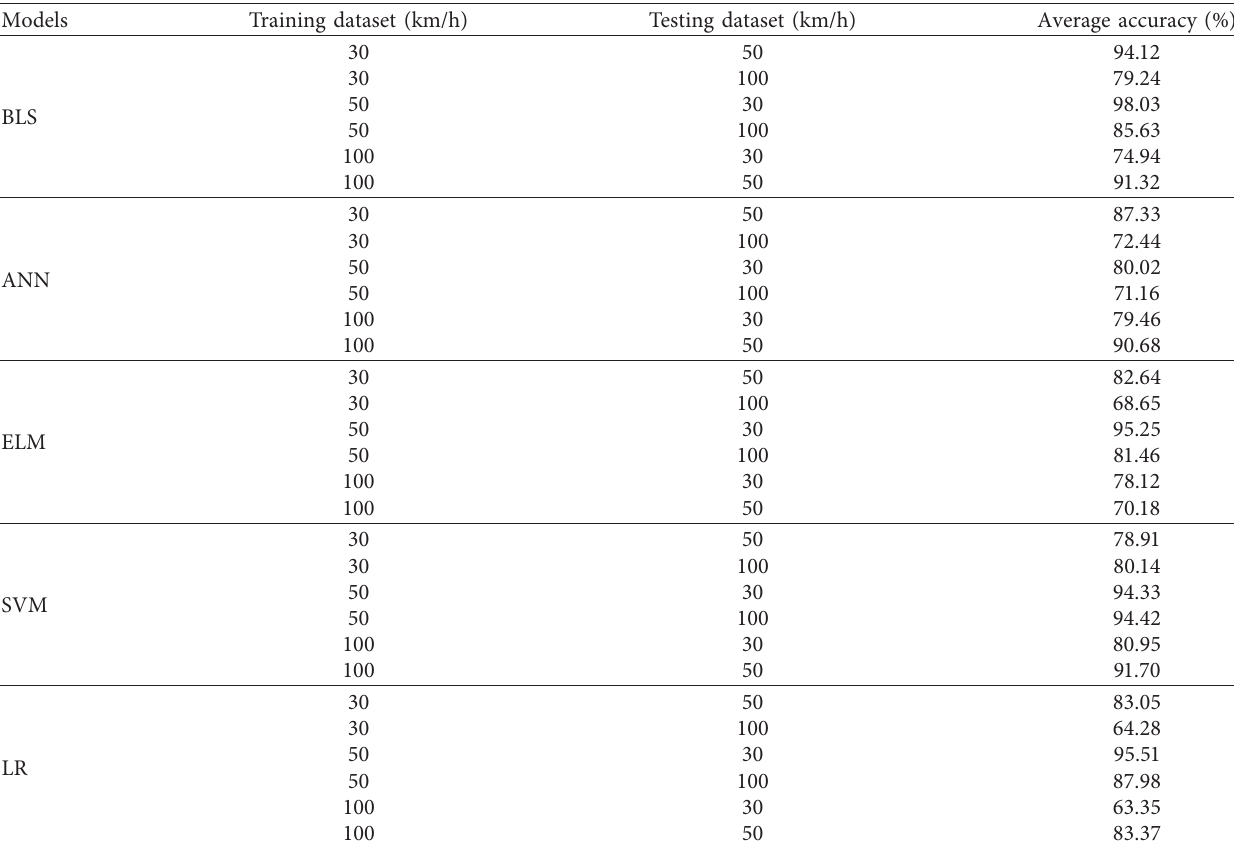
Figure 4: Results of 10 trials using BLS. Table 5: Classification comparison of different